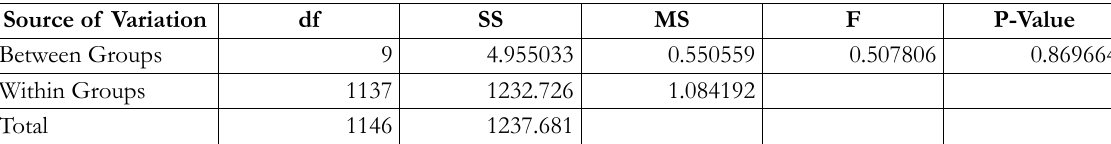
Table 22. Anova Table for Sensitization Effect